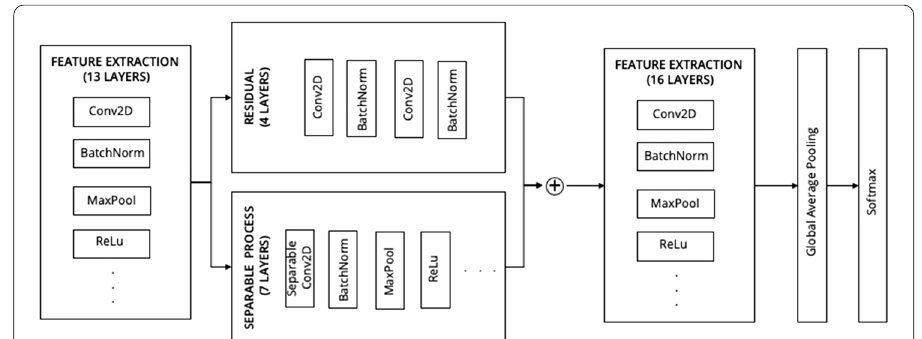
Fig. 1 Architecture with separable convolution and AVG pooling (ARCH-1)